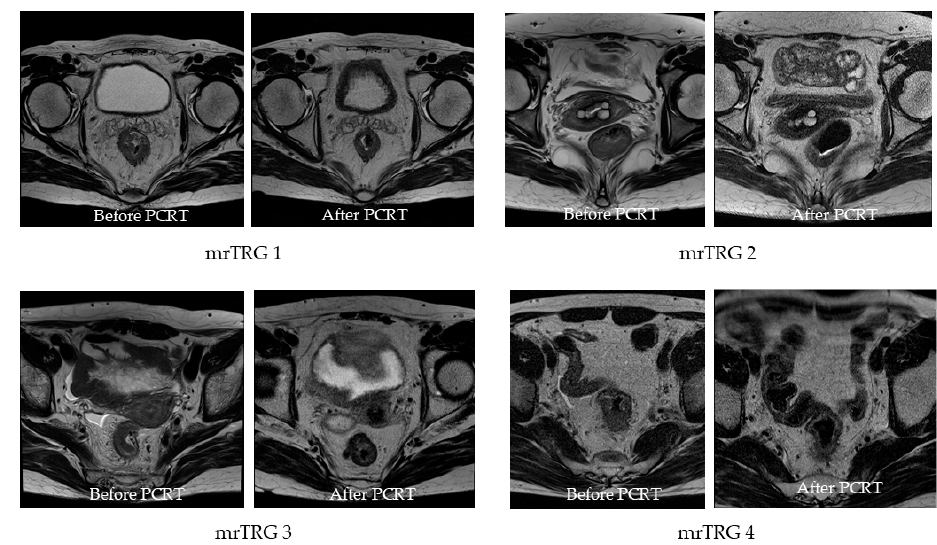
Figure 2. Tumor response after preoperative chemoradiotherapy (PCRT) with MRI as mrTRG. mrTRG, tumor regression grade evaluated with MRI; mrTRG1, complete regression; mrTRG2, near complete regression; mrTRG3, moderate regression; mrTRG4, minimal to no regression.